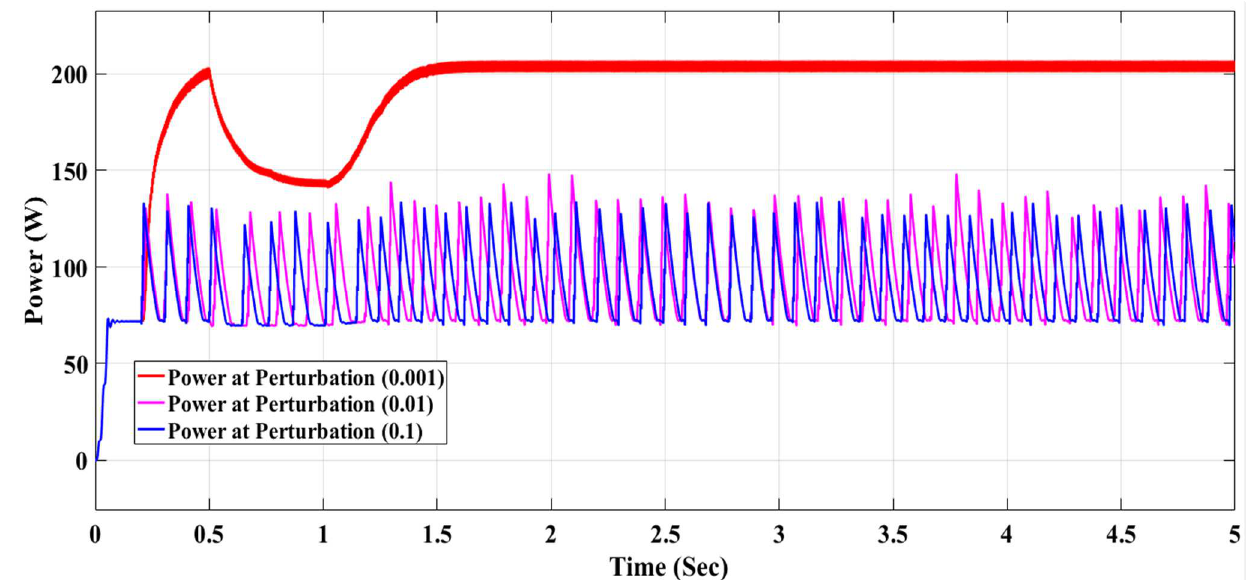
Figure 11. Output Power and Voltage of Hybrid RES with P-&-O MPPT.